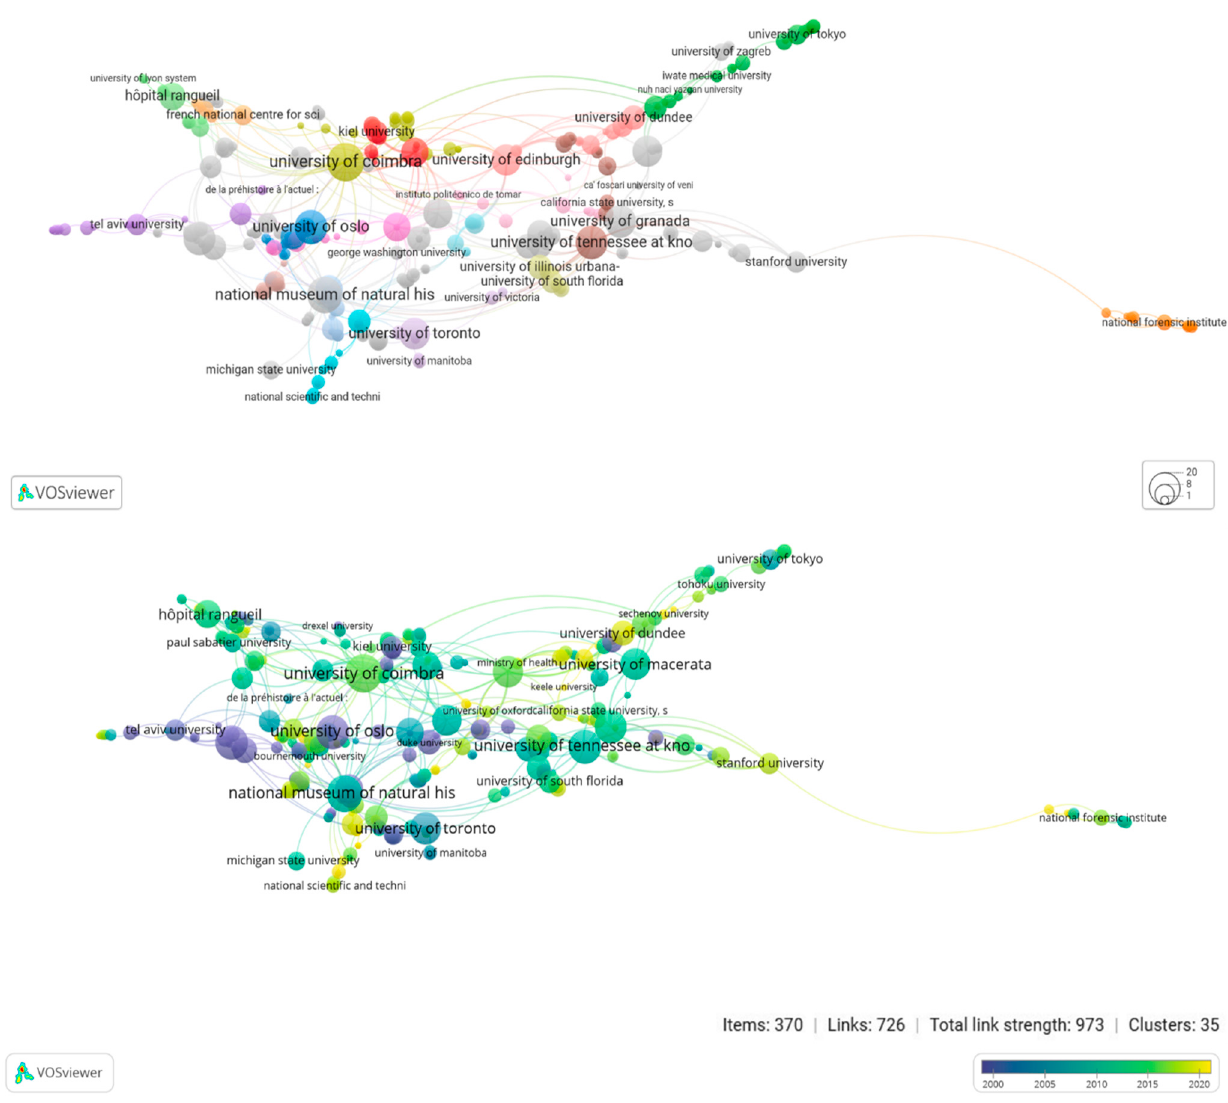
Figure 2. The upper image illustrates the network of publications co-authorship by institutions, while the lower image displays the same co-authorship network per year. The interactive map is accessible at https://app.vosviewer.com/?json=https://drive.google.com/uc?id=1wqzWo6Q8Xhl1VbaI5oWI18P2bXES jXcO (accessed on 15 January